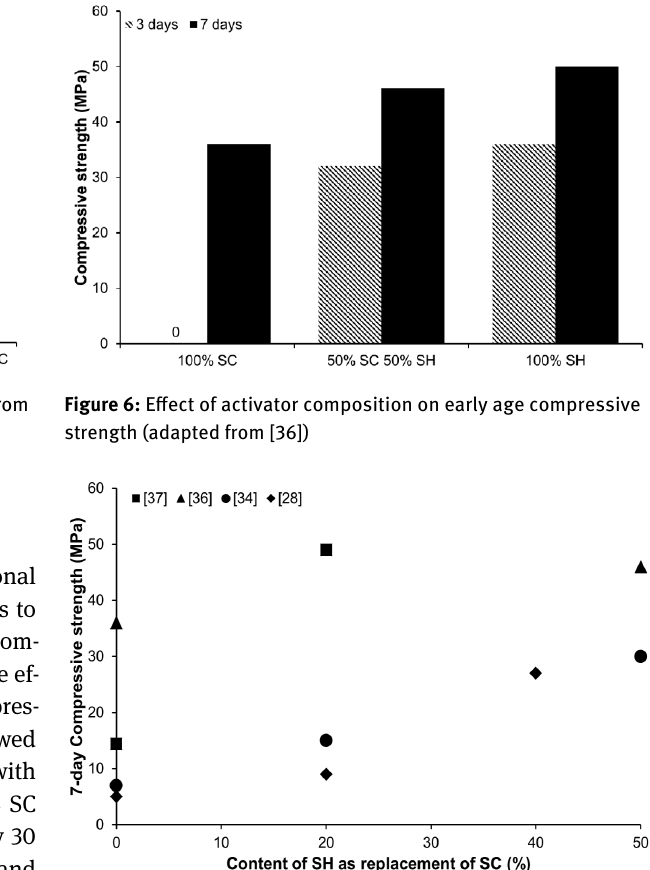
result in the inability of the surplus alkali to react with slag particles